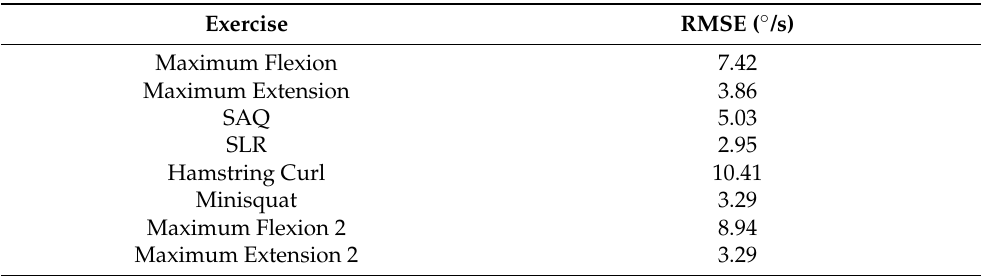
Table 3. Inter-rater reliability between the Knee Brace and OptiTrack Systems for each exercise for velocity measurements.